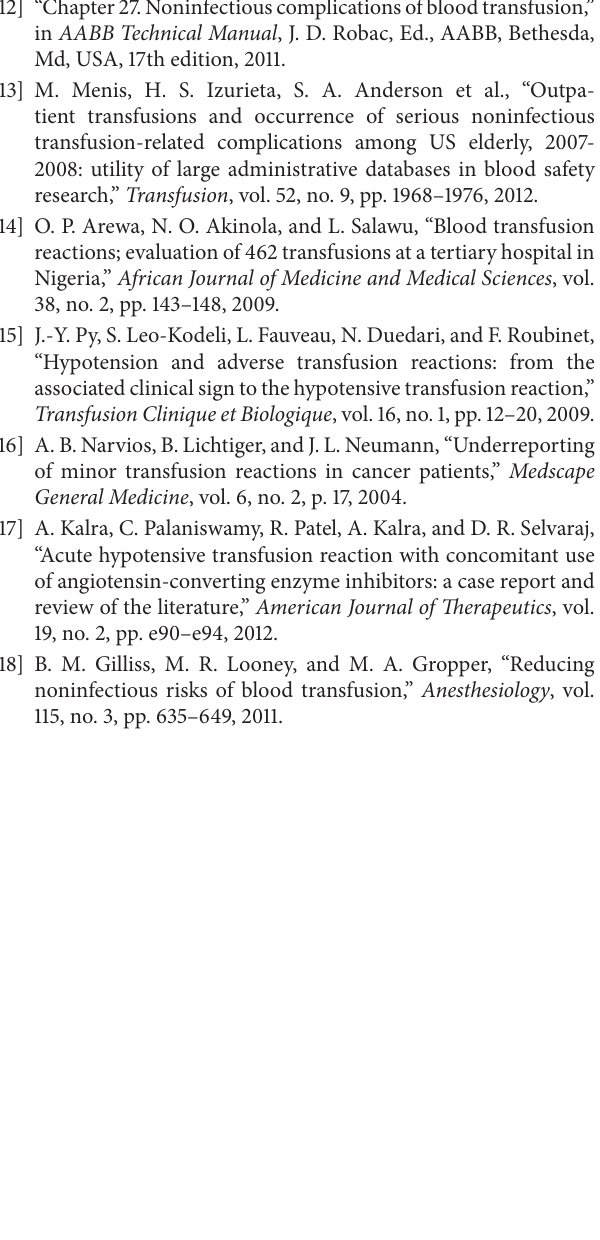
Percent out of 382 blood